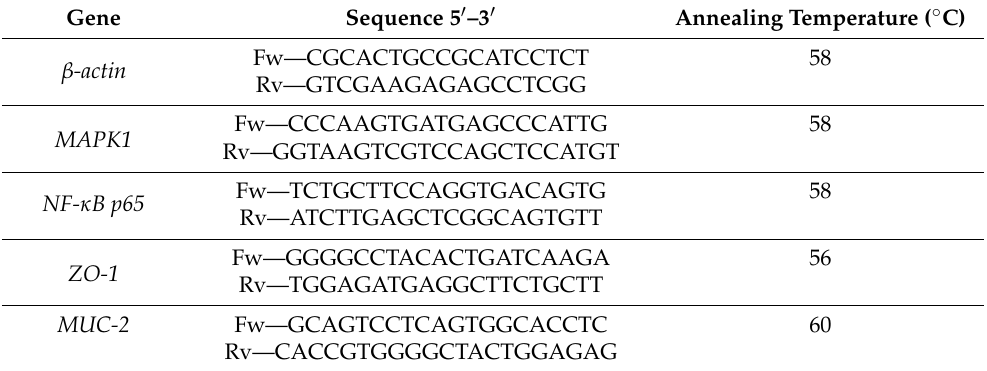
Table 6. Primer sequences used in real-time PCR assays. Beta-actin ( β -actin),